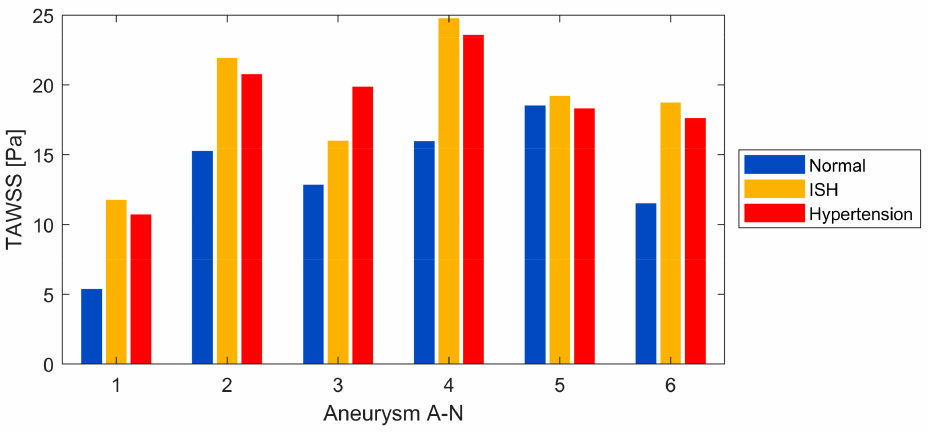
Figure 7. TAWSS at aneurysm surface, for each model and pressure condition.